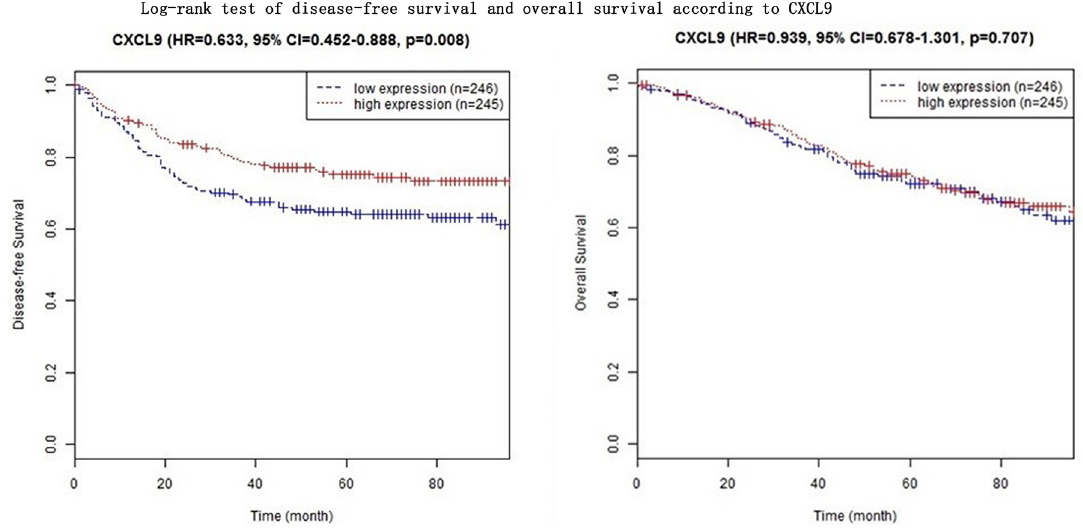
Fig 1. Log-rank test of disease-free survival and overall survival according to